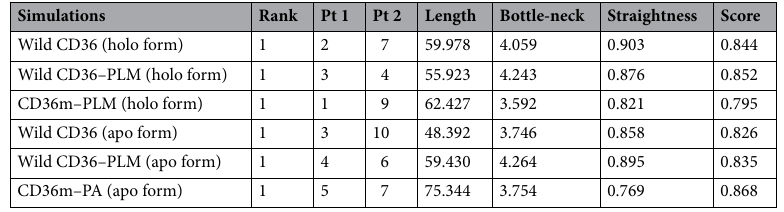
Table 1. Cavity’s profile as seen by the ChExVis